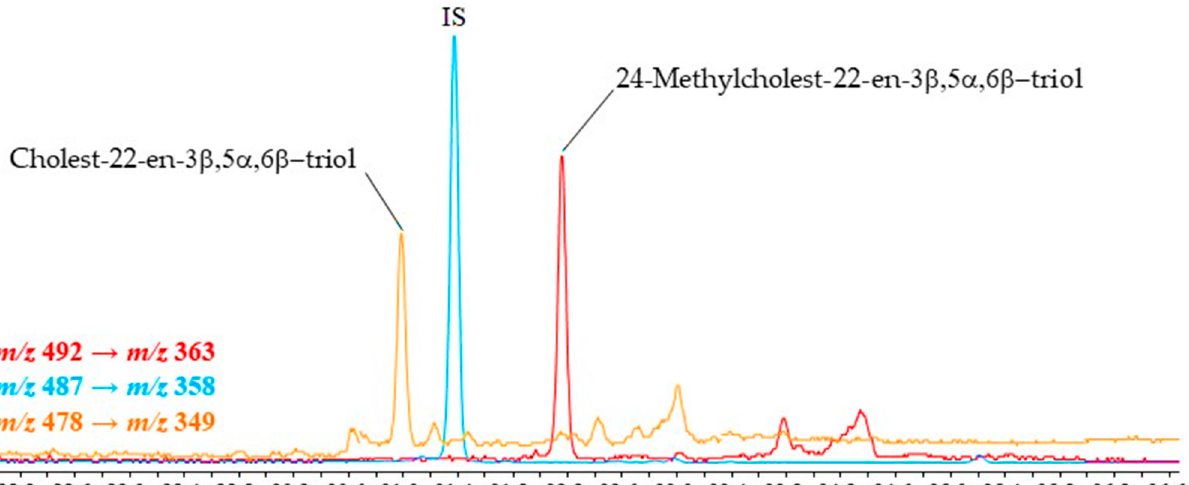
Figure 5. MRM chromatograms showing the presence of 3 β ,5 α ,6 β -steratriol trifluoroacetate deriva- tives in a total lipid extract (TLE) of dusts collected in the Negev desert (Israel) (IS = internal standard).